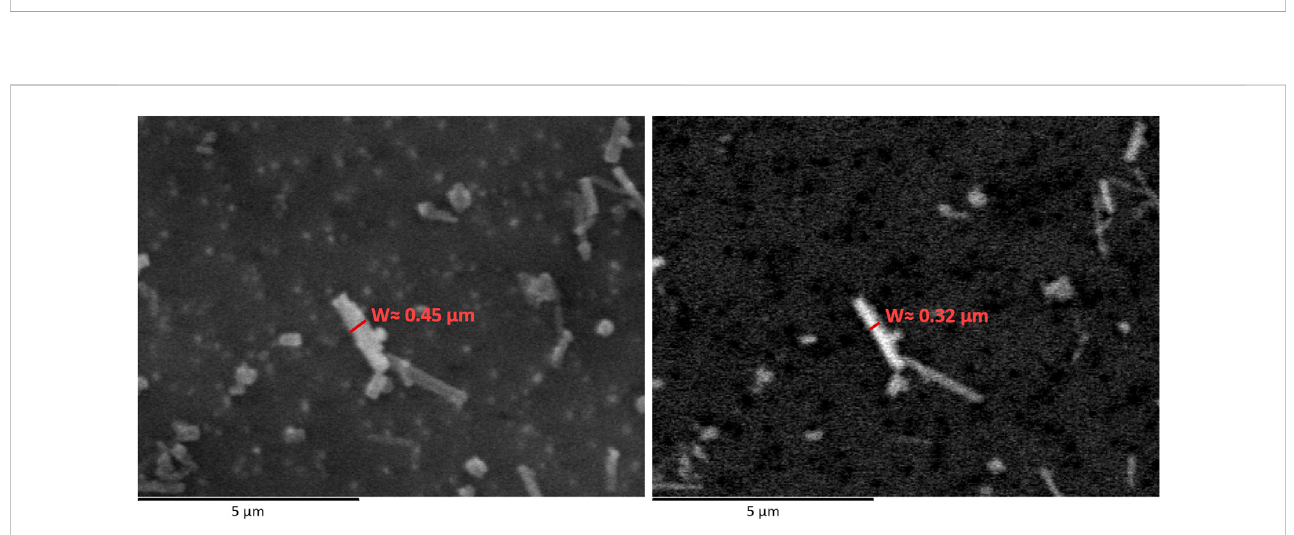
FIGURE 4 Comparison between a SE (left) and BSE micrograph (right) of the same elongated particle. On both images, the measured particle width is